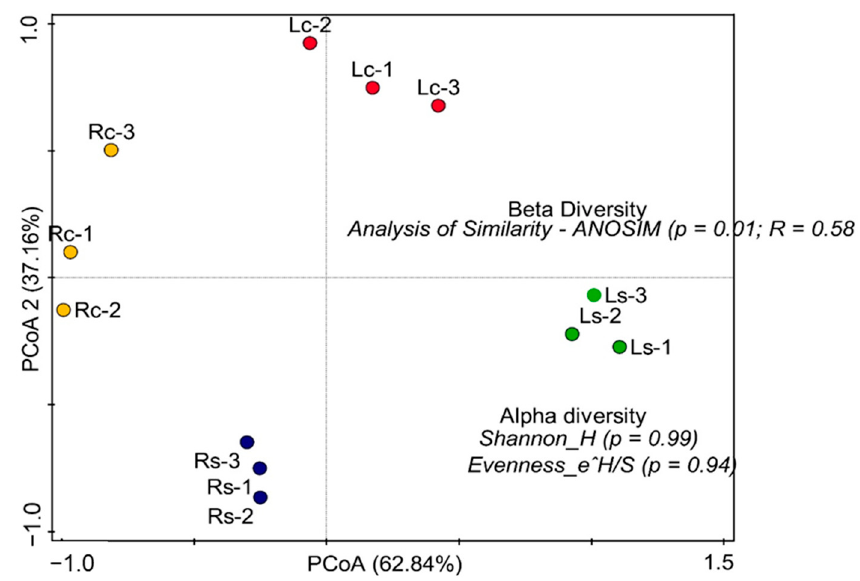
Figure 4. Similarity measure to compare functional categories obtained from sample sites using Principal Coordinate Analysis (PCoA). Using the Kruskal–Wallis one-way analysis of variance, Shannon and Pielou evenness indices (Alpha diversity) showed no significant difference within the replicates of each sample ( p = 0.99; 0.94). Beta diversity using Analysis of Similarity (ANOSIM) depicts differences between the sampling sites ( p = 0.01; R = 0.58). The result showed no significant difference within the functional attributes of the replicates in each sample, while Beta diversity revealed a wide difference between the samples and their controls at p < 0.05. Ls-1–3 (replicates of rhizosphere samples collected from Lichtenburg maize farm), Rs-1–3 (replicates of rhizosphere samples collected from Randfontein maize farm), Lc-1–3 (replicates of bulk samples collected from Lichtenburg maize farm), and Rc-1–3 (replicates of bulk samples collected from Randfontein maize